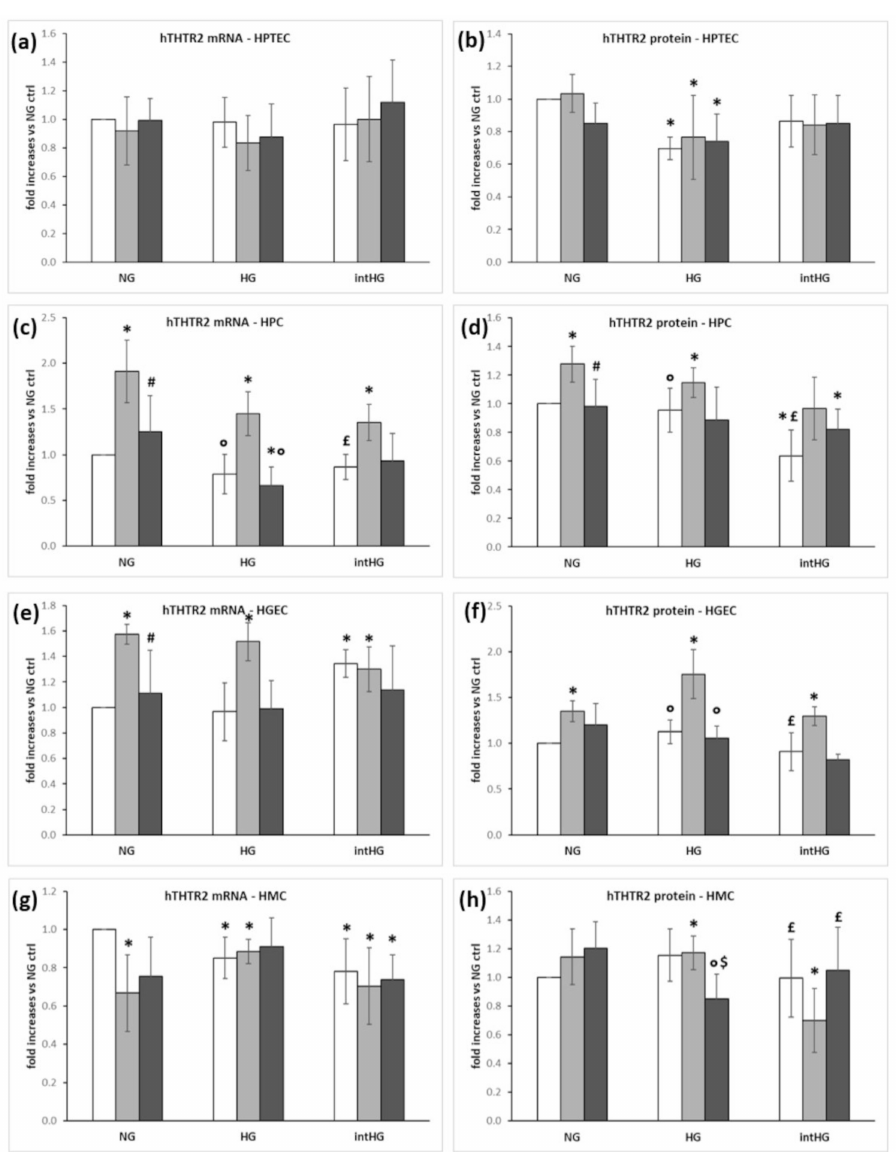
Figure 4. THTR2 expression in renal glomerular cells under different experimental conditions. ( a ) THTR2 mRNA and ( b ) protein expression in HPTEC; ( c ) THTR2 mRNA and ( d ) protein expres- sion in HPC; ( e ) THTR2 mRNA and ( f ) protein expression in HGEC; ( g ) THTR2 mRNA and ( h ) protein expression in HMC. White bars: physiological thiamine concentrations (ctrl); light grey bars: thiamine-deficient medium (TD); dark grey bars: high thiamine concentrations (HT). NG = physiological glucose concentrations; HG = high glucose concentrations; intHG = intermittent high glucose concentrations. Mean of 5 experiments ± SD. * p < 0.05 vs. NG ctrl; # p < 0.05 vs. NG TD; ◦ p < 0.05 vs. HG TD; £ p < 0.05 vs. intHG TD; $ p < 0.05 vs. HG